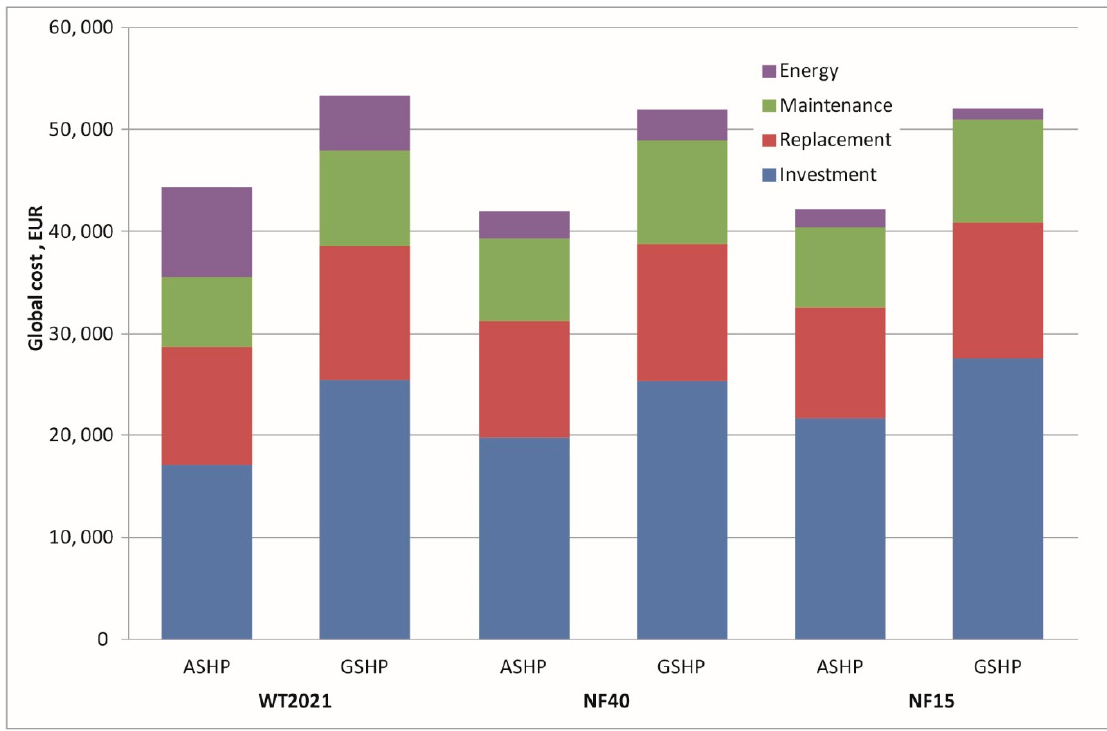
Figure 6. The global cost for all variants.